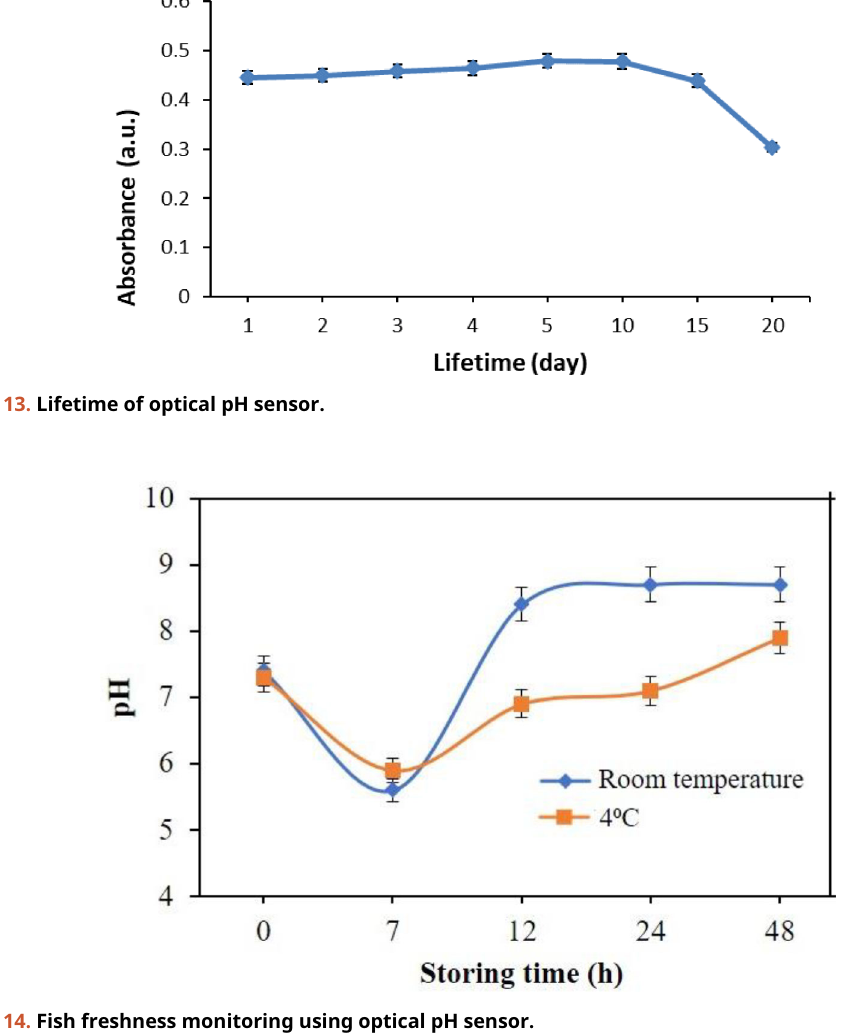
Figure 14. Fish freshness monitoring using optical pH